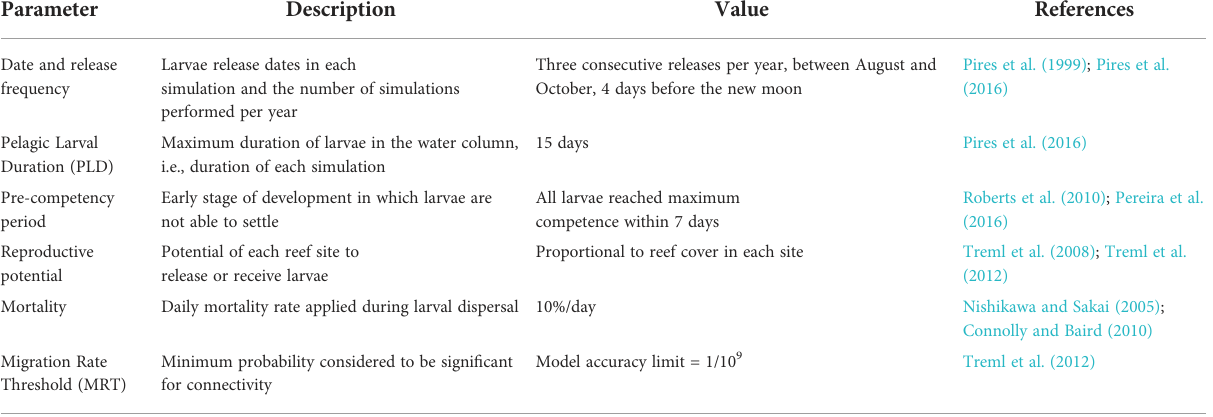
TABLE 1 Life-history traits of Mussismilia hispida used for the larval connectivity model.